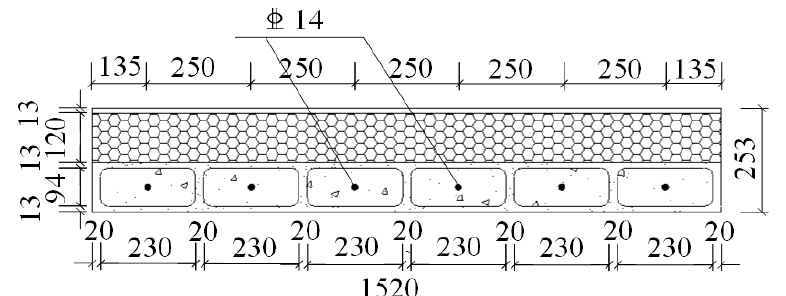
Figure 2. Plan view of CEW specimen.